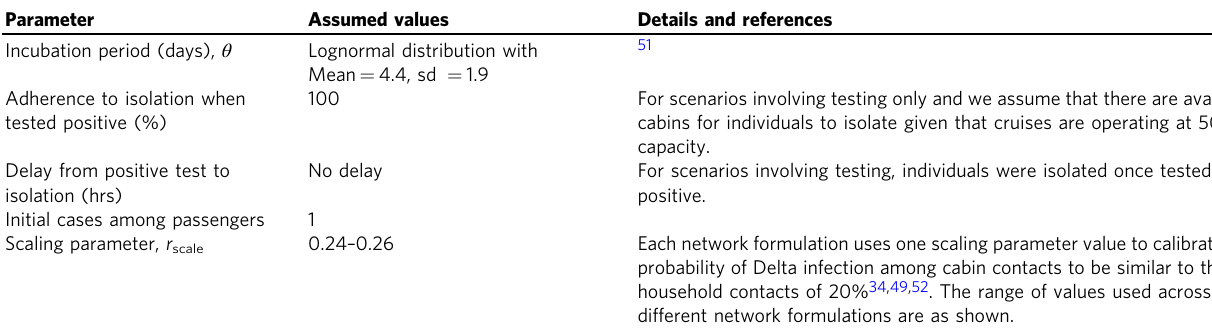
Table 3 Parameter values and